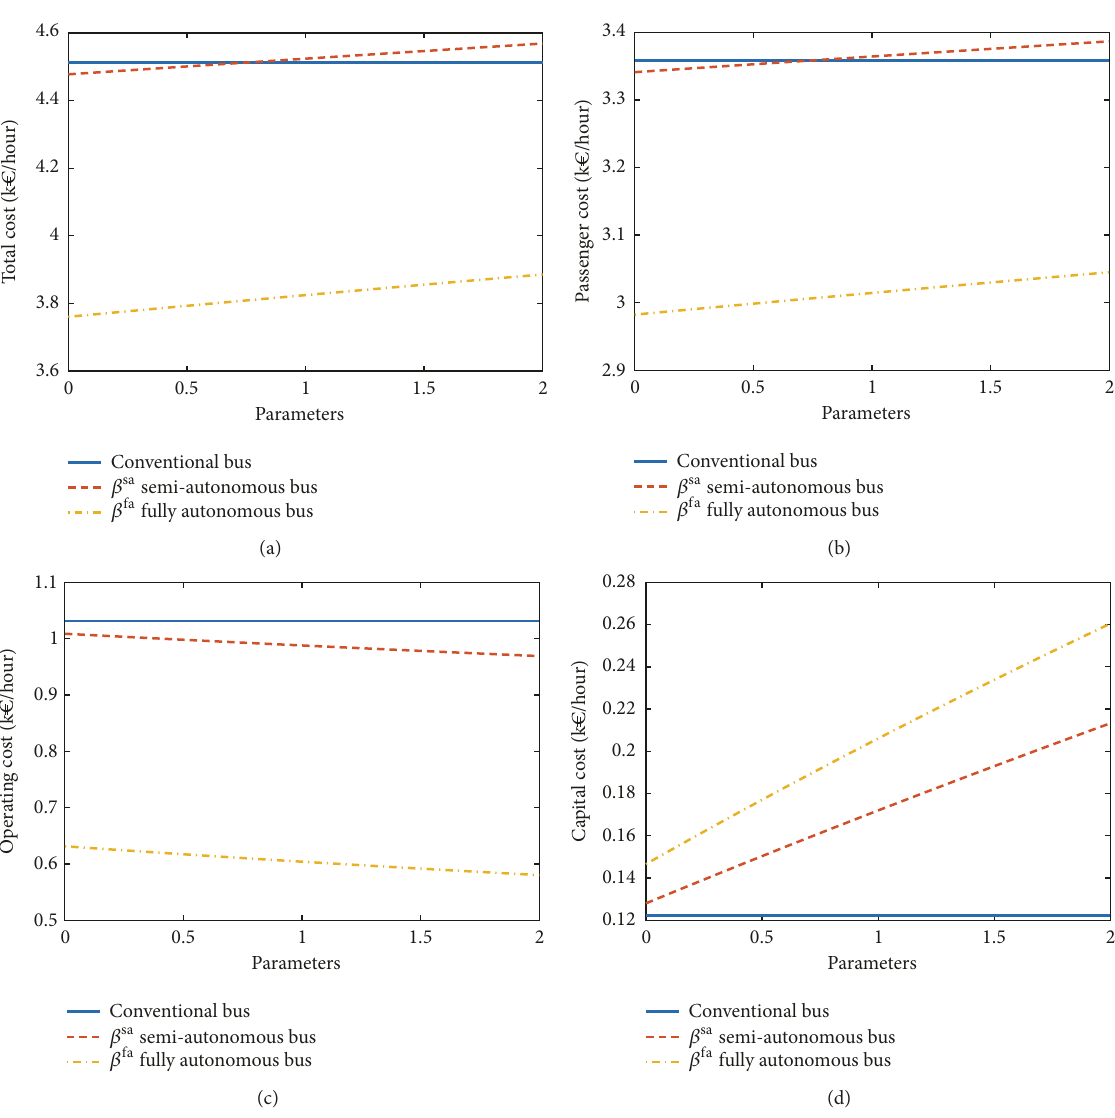
Figure 3: (a) Total cost, (b) passenger cost, (c) operating cost, and (d) capital cost as functions of parameters 𝛽 sa and 𝛽 fa . Other parameters according to Table